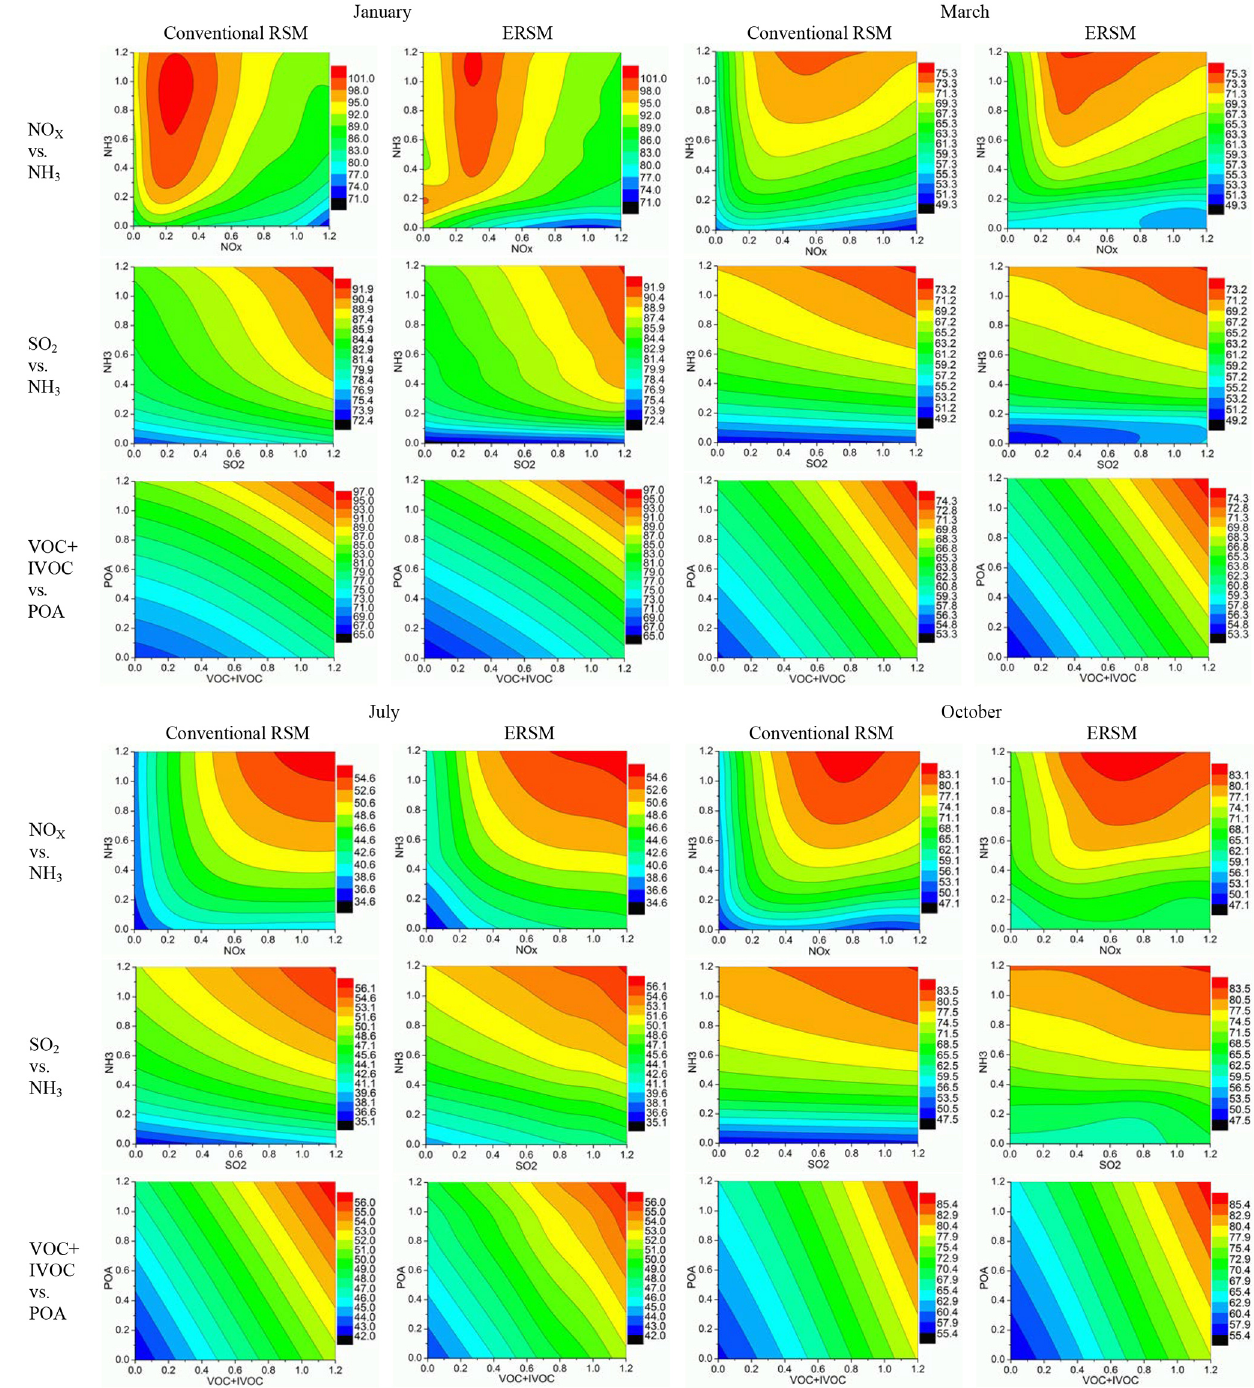
Figure 3. Comparison of the 2-D isopleths of PM 2 . 5 concentrations in Beijing in response to the simultaneous changes in precursor emissions in all five regions derived from the conventional RSM technique and the ERSM technique. The x and y axes represent the emission ratio, defined as the ratios of the changed emissions to the emissions in the base case. The color contours represent PM 2 . 5 concentrations (unit: µgm − 3 )